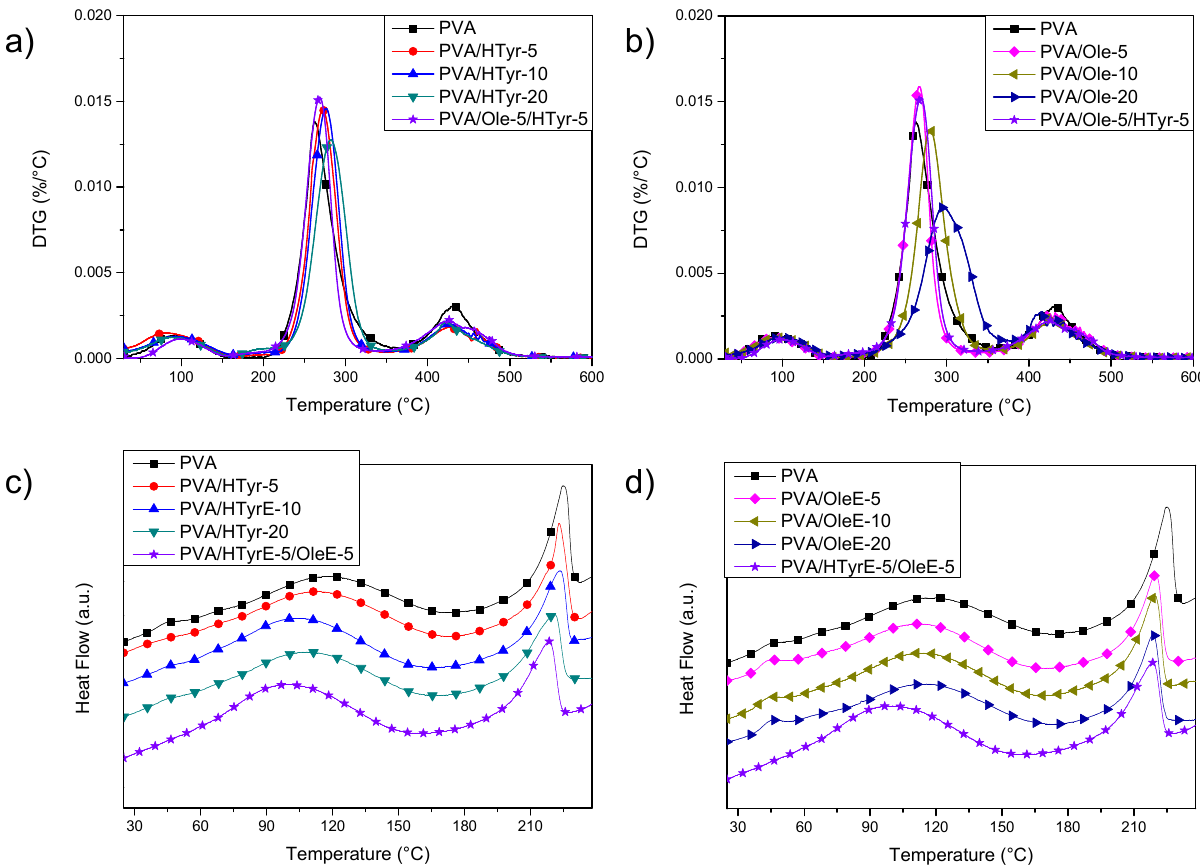
Figure 8. DTG curves ( a , b ) and first differential scanning calorimetry (DSC) heating scans ( c , d ) for neat PVA, PVA/HTyrE and PVA/OleE films.